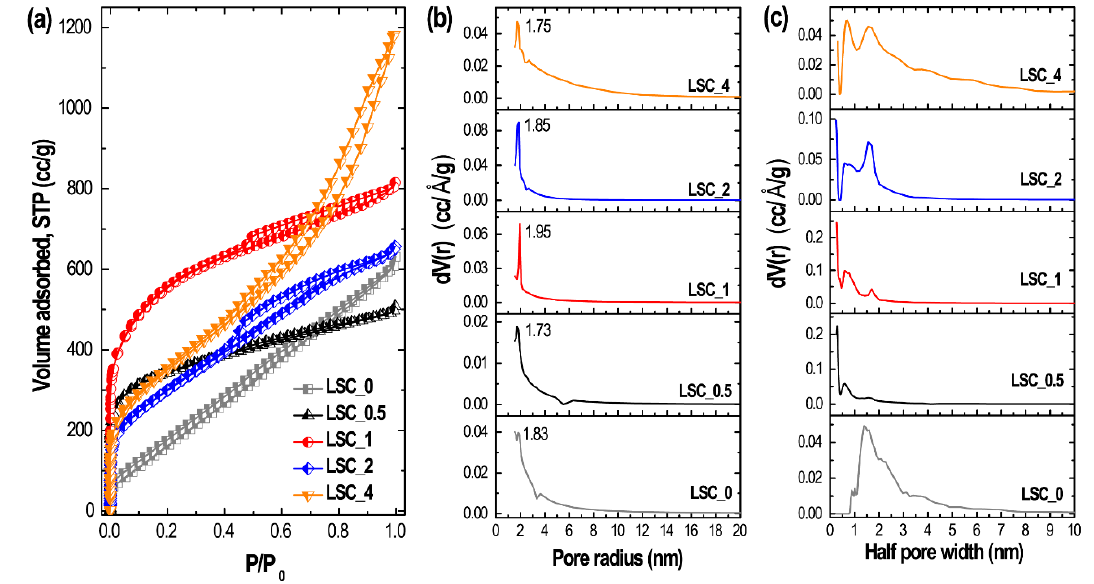
Figure 4. ( a ) Nitrogen adsorption / desorption isotherm of LSC_0.5 , LSC_1 , LSC_2 and LSC_4 , ( b ) pore size distribution obtained by the Barrett–Joyner–Halenda (BJH) method and ( c ) pore size distribution obtained by the density functional theory (DFT) method.